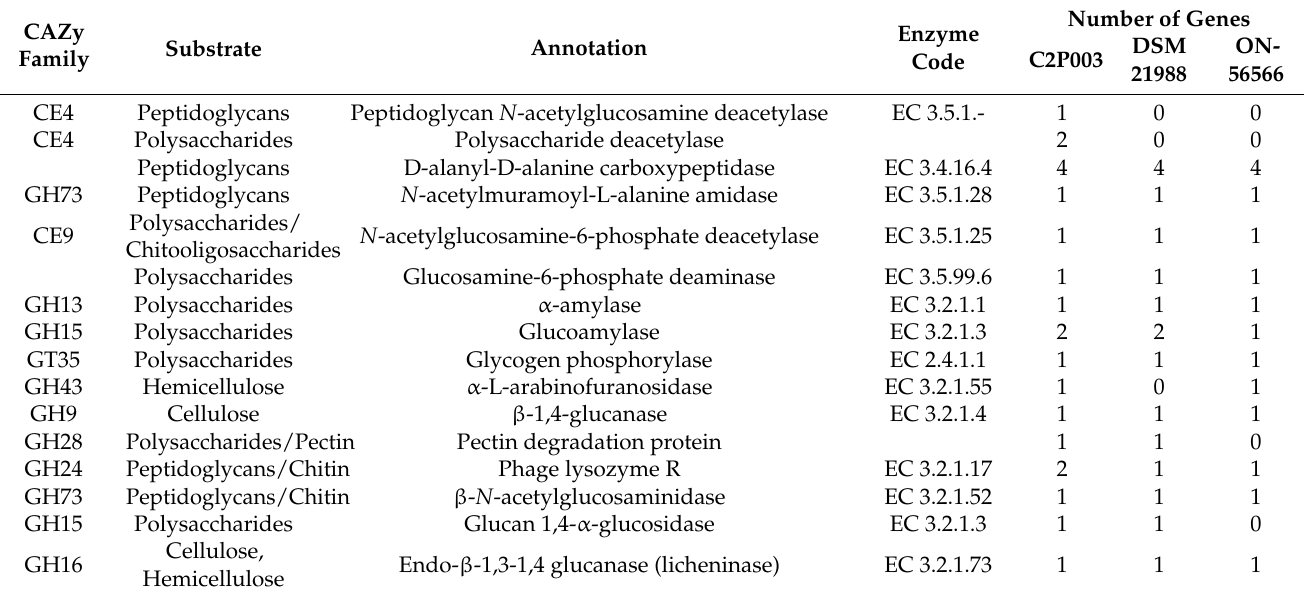
Table 3. Predicted plant and microbial cell wall-degrading enzymes of strains A. altamirensis C2P003, DSM 21988 and